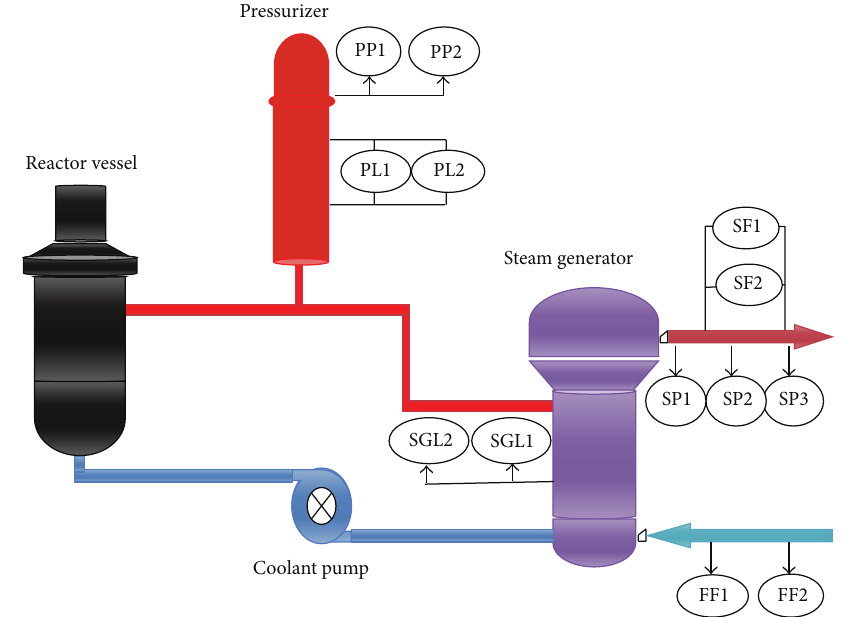
Figure 5: Spatial distribution of selected sensor set.